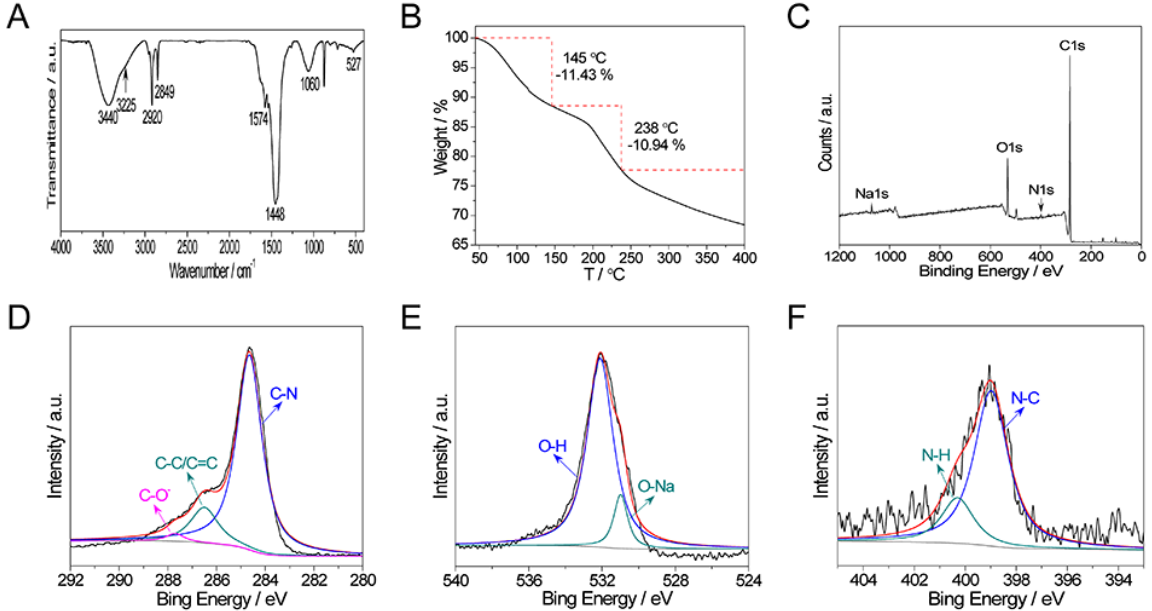
Figure 1. Analyses of the structure and composition of Ala-C 60 . ( A ) FTIR spectrum. ( B ) TGA curve. ( C ) XPS survey. ( D – F ) High-resolution XPS spectra of C1s, O1s, and N1s. Table 1. The element analysis of Ala − C 60 . Weight (mg)